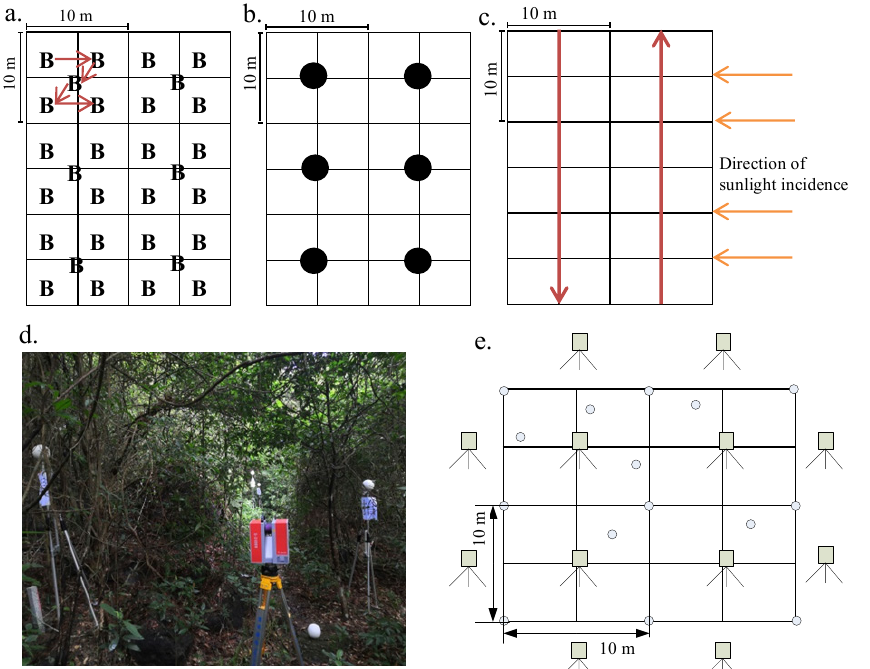
Figure 2. Measurement schemes for obtaining LAI by different indirect methods. ( a ) Measurement route of LAI-2200 B-value; ( b ) Camera shooting point for DHP; ( c ) Measurement route for TRAC; ( d ) Field measurement scenes for TLS; ( e ) Instrument and target ball site locations for TLS.